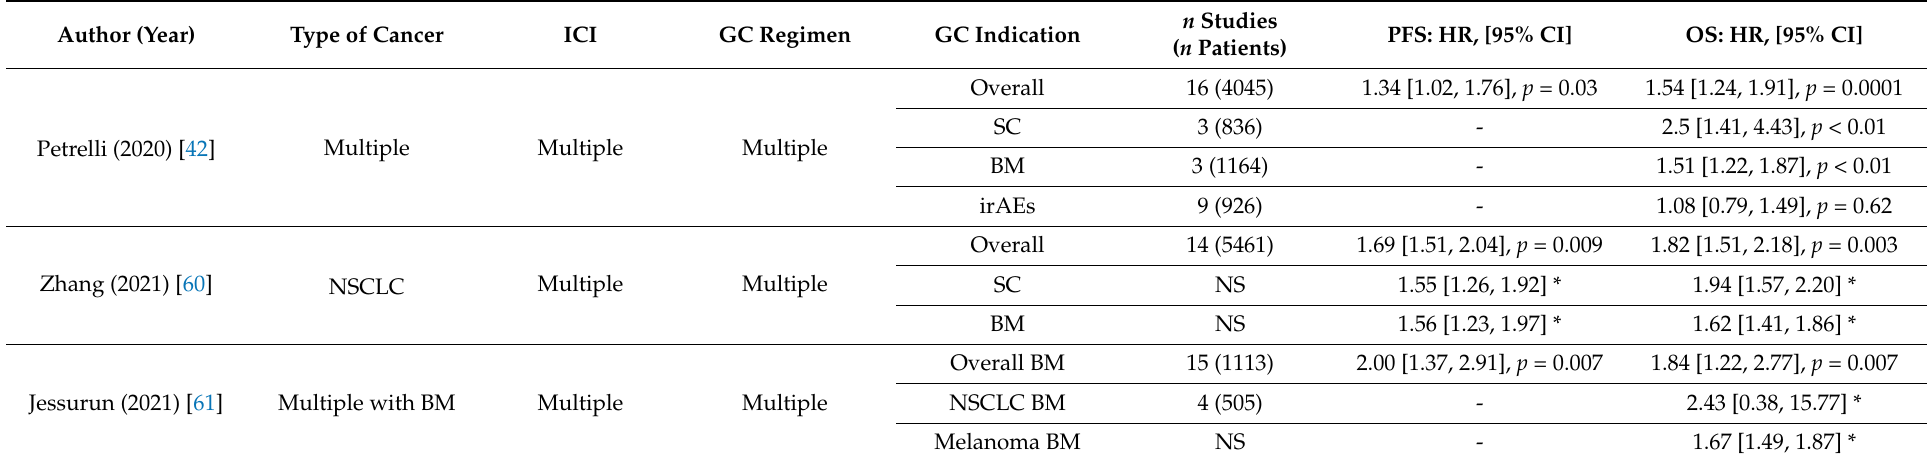
Table 2. Systematic reviews and meta-analyses on the impact of corticosteroids with ICI treatment on survival